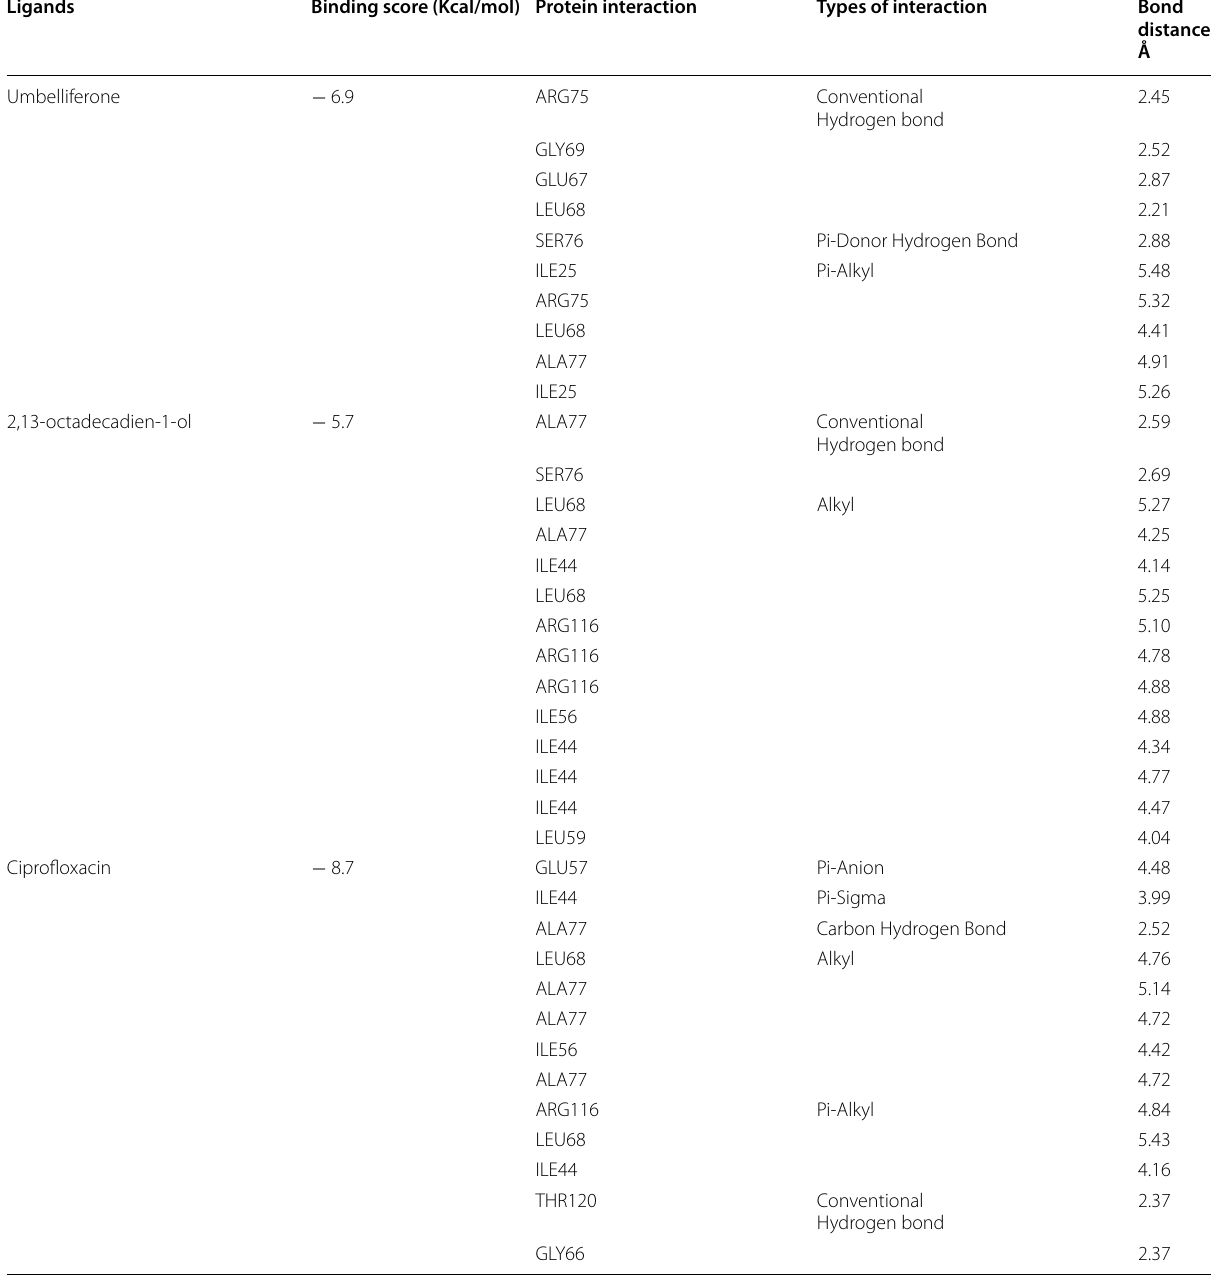
Table 4 Result of the binding scores of the isolated compounds/ciprofloxacin with target receptor (PDB: 2OZ6) Ligands Binding score (Kcal/mol) Protein